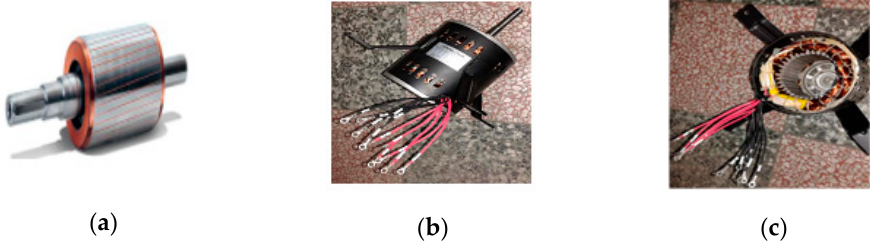
Figure 13. Photo pictures of a SCSCRIM in Style D: ( a ) copper squirrel cage rotor; ( b ) combination of stator, rotor and six windings; ( c ) full cross of stator and six windings.